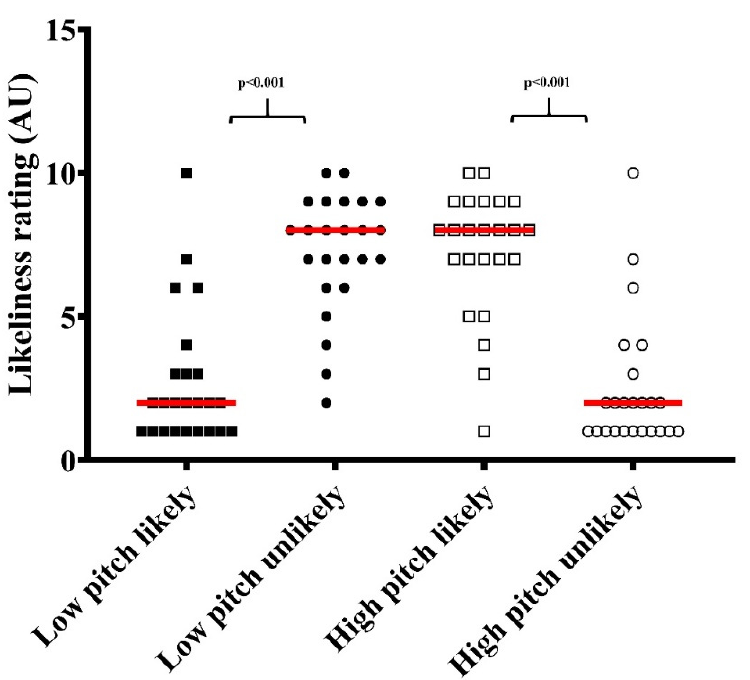
Figure 4. Real-life based likeliness ratings of high and low pitch likely and unlikely test events. Data are presented as grouped dot plots and medians. AU = arbitrary units.